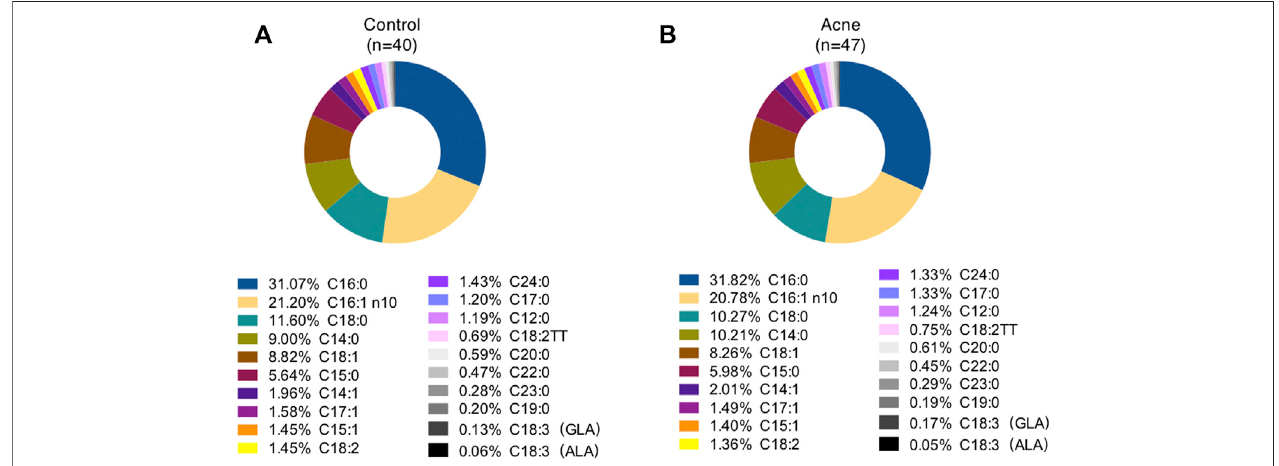
FIGURE 1 | Percentage of total fatty acids in sebum from control subjects (A) and acne patients (B) . GLA, γ -linolenic acid; ALA, α -linolenic acid.